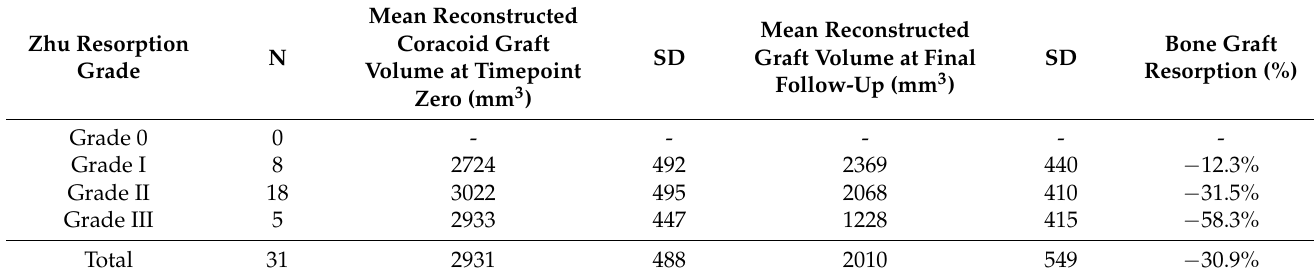
Table 1. Mean modeled coracoid graft volume at timepoint zero (mm 3 ) and mean reconstructed